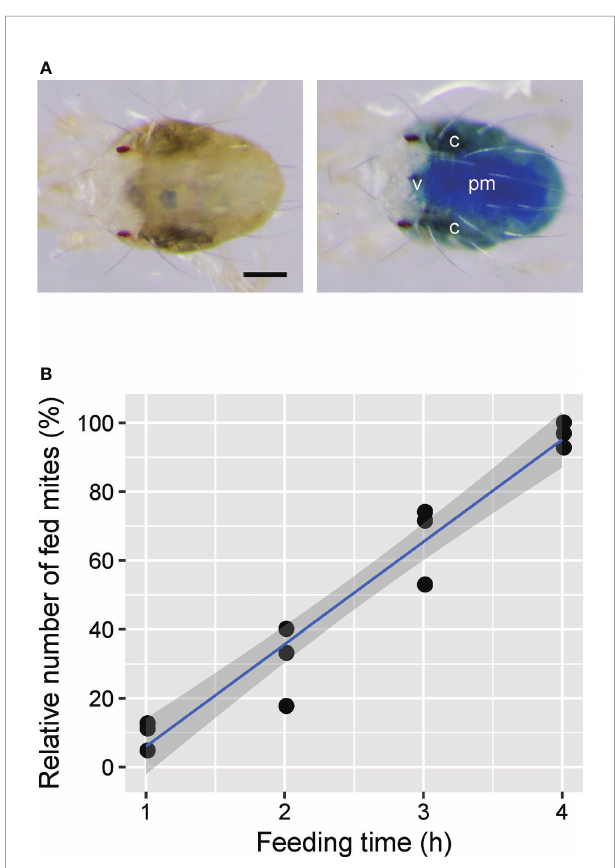
FIGURE 2 | Ef fi ciency of oral administration to Tetranychus urticae using the feeding device. (A) Adult females kept on the feeding device in which a 1% (w/v) blue tracer dye (Brilliant Blue FCF) was excluded (left) or included (right) at 25°C for 24 h after molting. C, caeca; v, ventriculus; pm, posterior midgut. Scale bar: 100 µm. (B) The relationship between the feeding time and relative number of fed mites. Newly molted adult females were placed onto the feeding device using a nylon mesh sheet (2 × 2 cm) with a 100-µm opening, and ingestion was determined by the change of body color. Data were collected from three independent experimental runs and are represented with a regression line and a 95% con fi dence interval band. n = 127 –